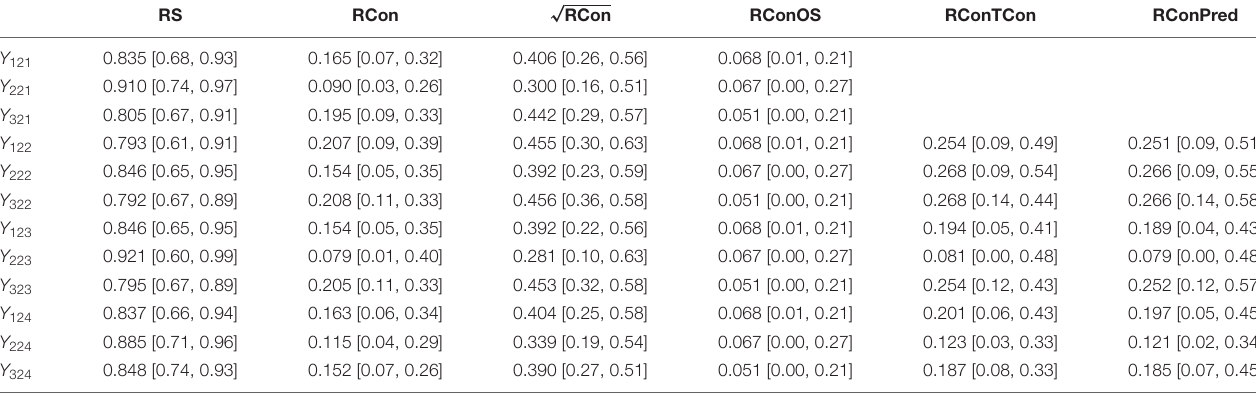
TABLE 3 | Results of the MR-LST-AR